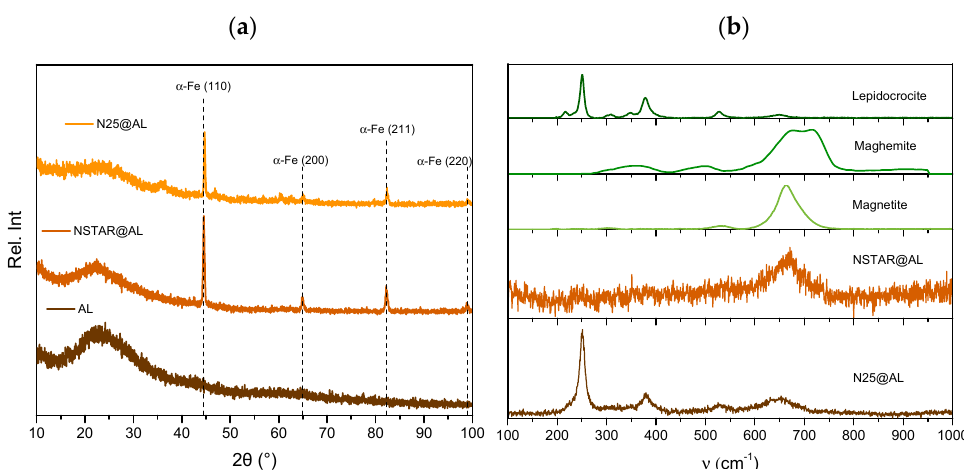
Figure 2. ( a ) XRD pattern for pure AL beads, and NSTAR@AL and N25@AL nanocomposites. ( b ) Raman spectra of samples NSTAR@AL and N25@AL. The Raman spectra of maghemite, lepidocrocite, and magnetite are also included for reference. KL alginate was used.